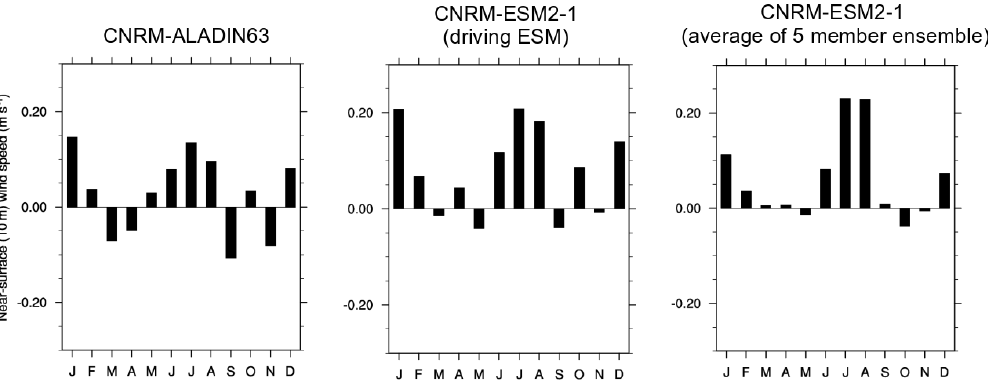
Figure 7. Near-surface wind speed evolution (ms − 1 ) between the past period (1971–2000) and the future period (2021–2050) according to the SSP 5-8.5 over the East African region with the CNRM-ALADIN63 model and its driving